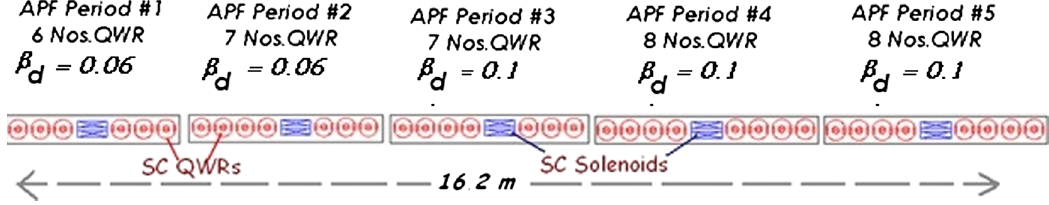
FIG. 1. Layout showing the configuration of cryomodules consisting of SC QWRs and